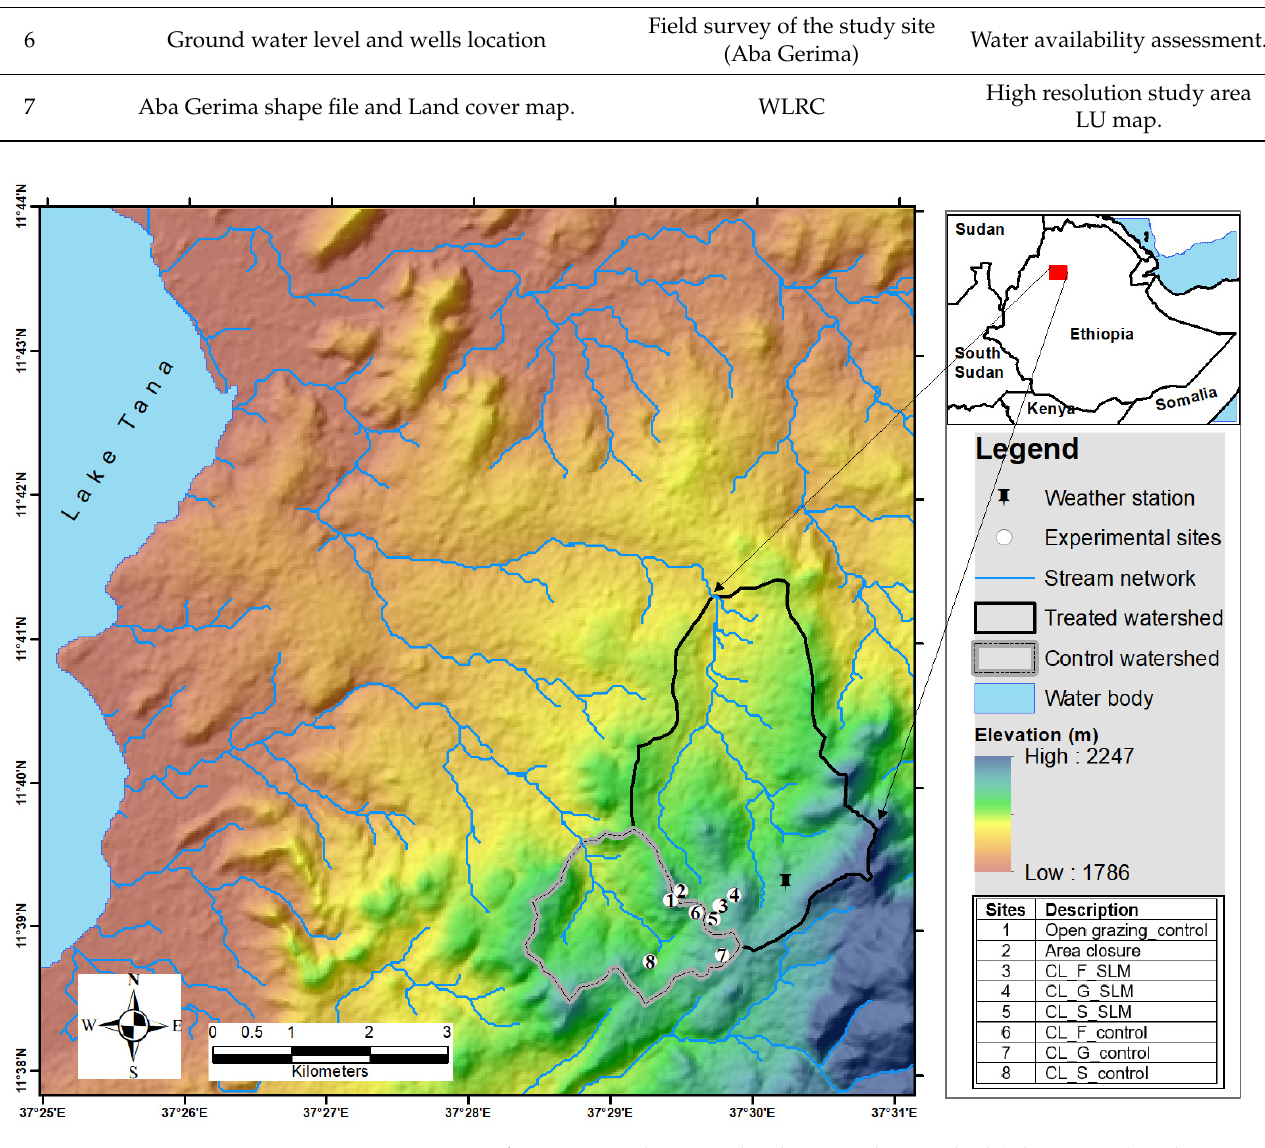
Figure 1. Location of experimental sites under the treated watershed (Aba Gerima) and untreated watershed (Site 1: Open grazing land (control), Site 2: Area closure, Site 3: cultivated land (CL) under Flat (F) with Sustainable Land Management (SLM), Site 4: CL under Gentle (G) with SLM, Site 5: CL under steep (S) with SLM, Site 6: CL under Flat (F) control, Site 7: CL under Gentle (G) control, and Site 8: CL under steep (S) control. Table 1. Data type used in the study and their respective sources.